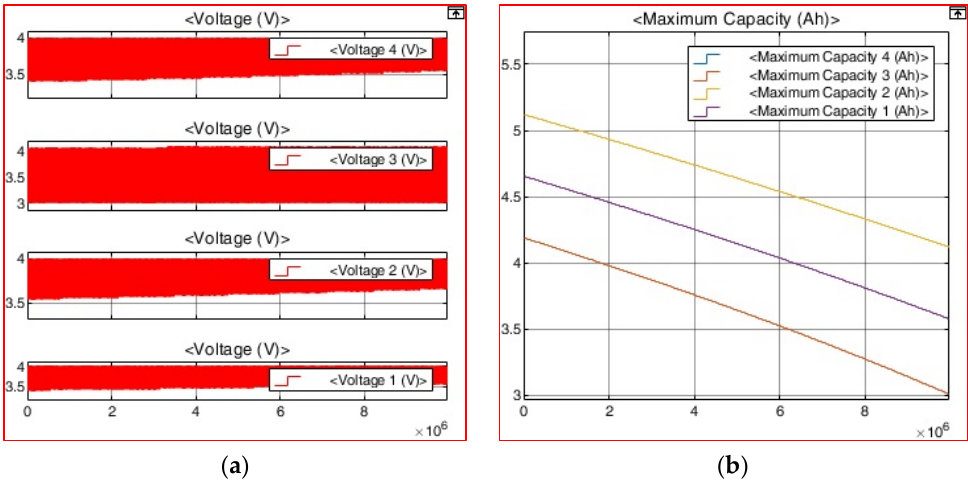
Figure 9. Series connection aging simulation with ±10% capacity deviation. ( a ) Voltage results. ( b ) SOH results.